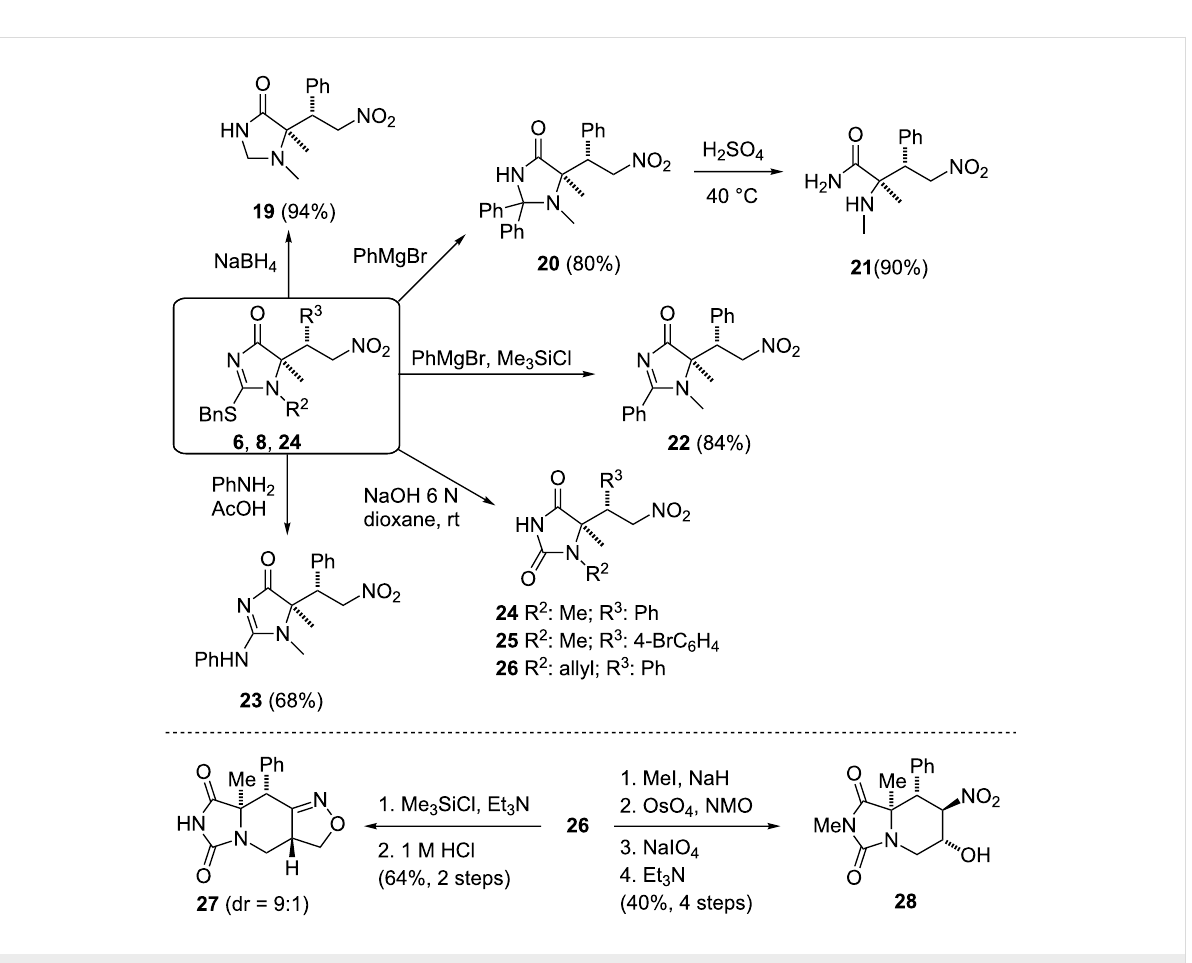
Scheme 4: Elaboration of the Michael adducts coming from the Michael addition to nitroalkenes